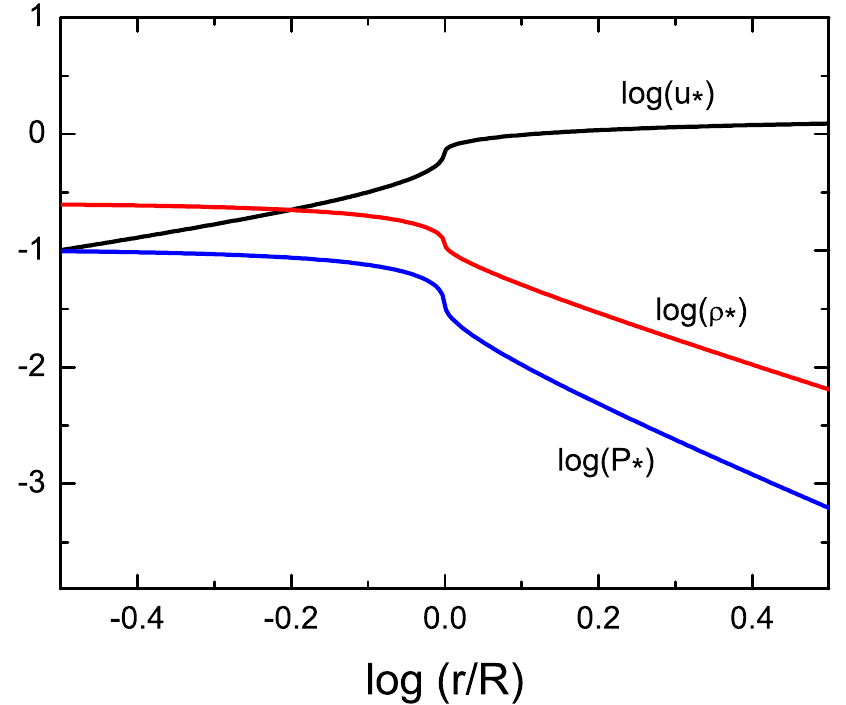
Figure 3. The steady-state wind solution as a function of radius r / R for the CC85 model, where R is the radius of the wind launching region, and the dimensionless variables are given by u = u